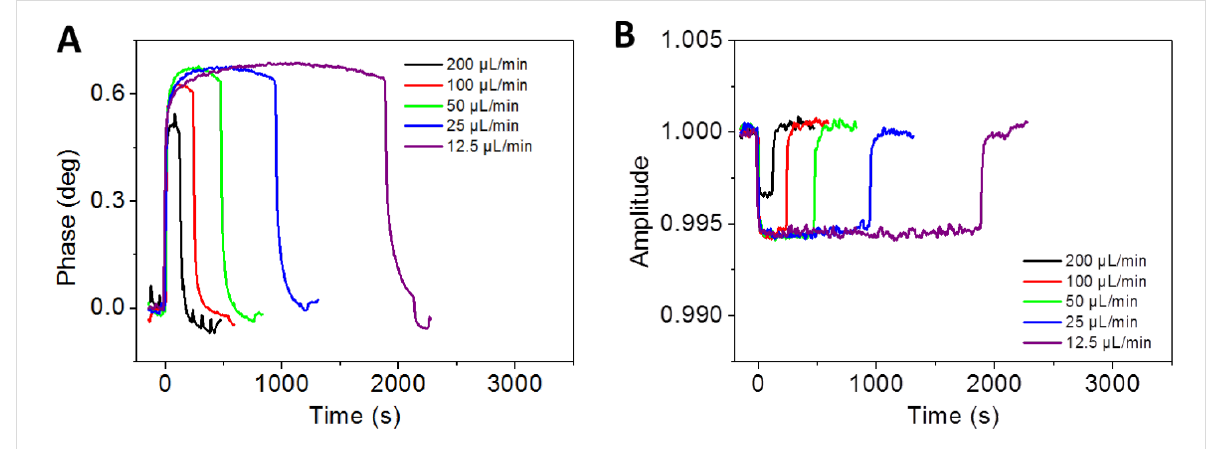
Figure 2: Flow-rate dependency of calcium carbonate interactions with COO-SAM chip. Phase vs time plot (A) and corresponding amplitude vs time plot (B) for different flow rates. A constant volume of 400 µL calcium carbonate in pure water (140 µmol/L) was injected, followed by pure water for 5